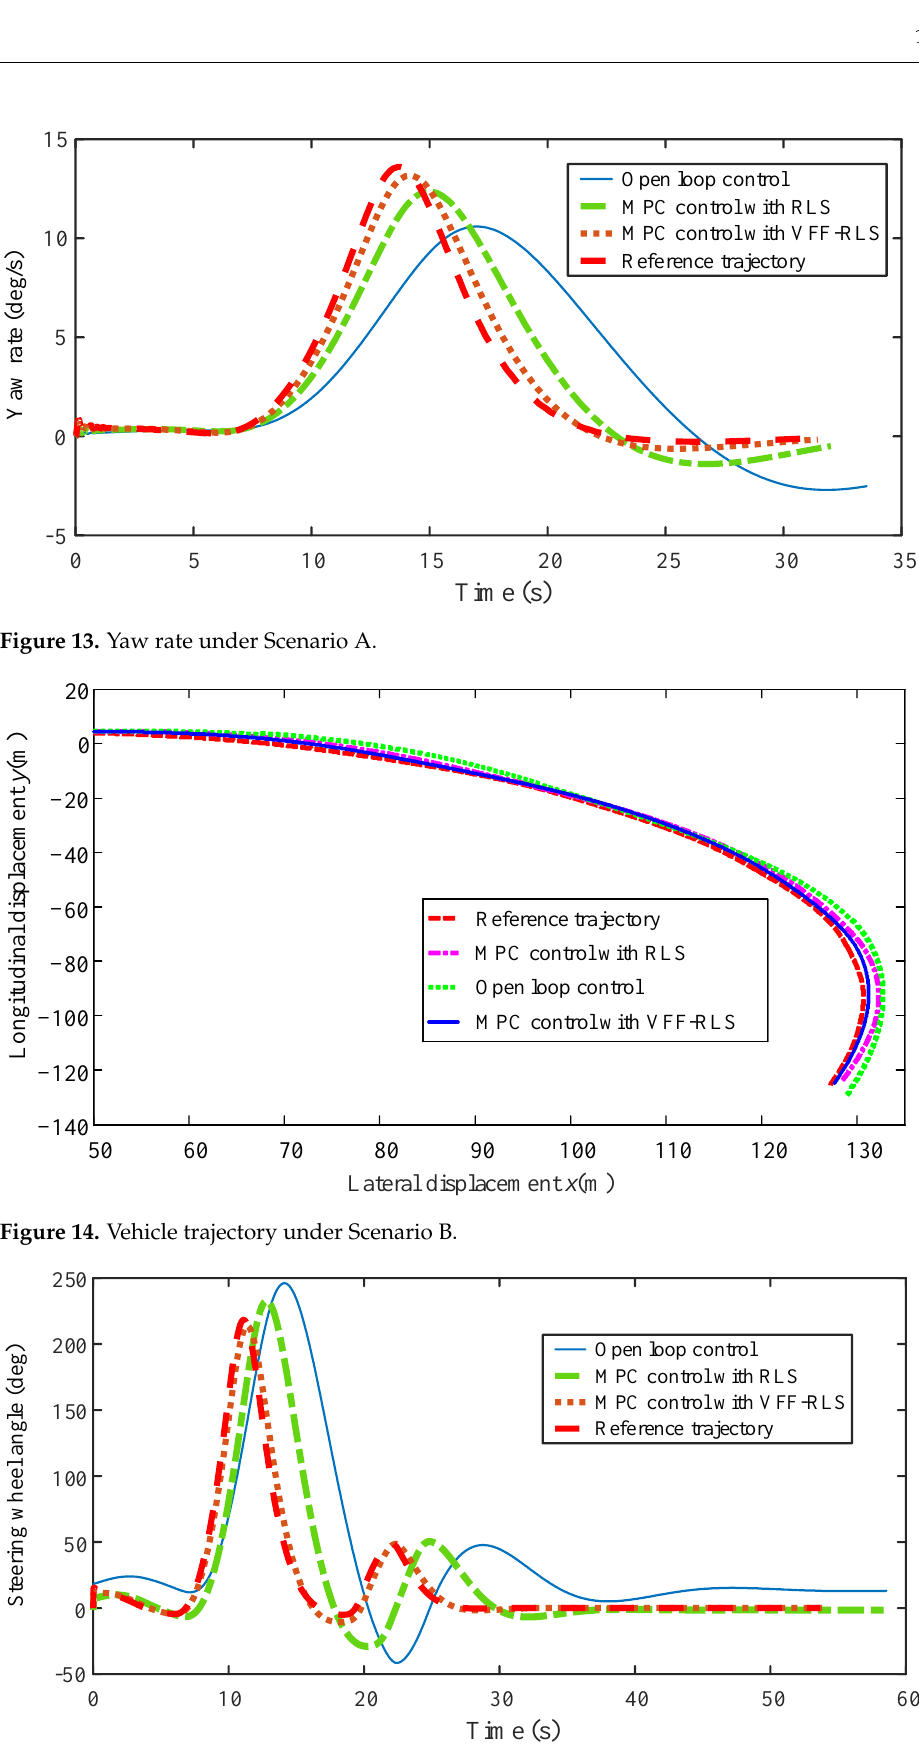
Figure 16. Lateral deviation under Scenario B.